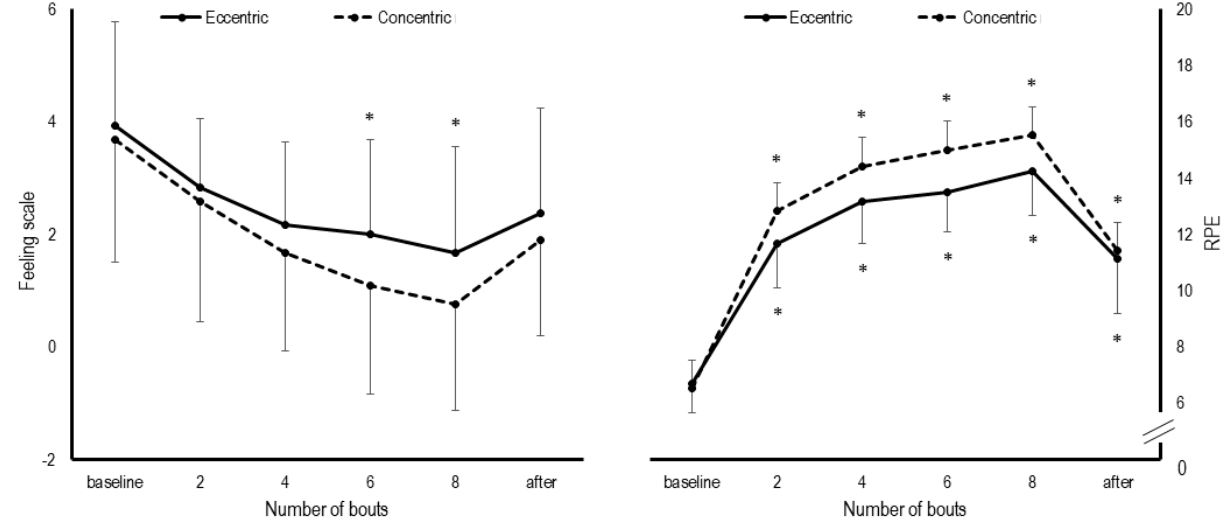
Figure 2. Differences in the Feeling Scale and Rating of Perceived Exertion (RPE) between protocols. * p < 0.05 compared to baseline.